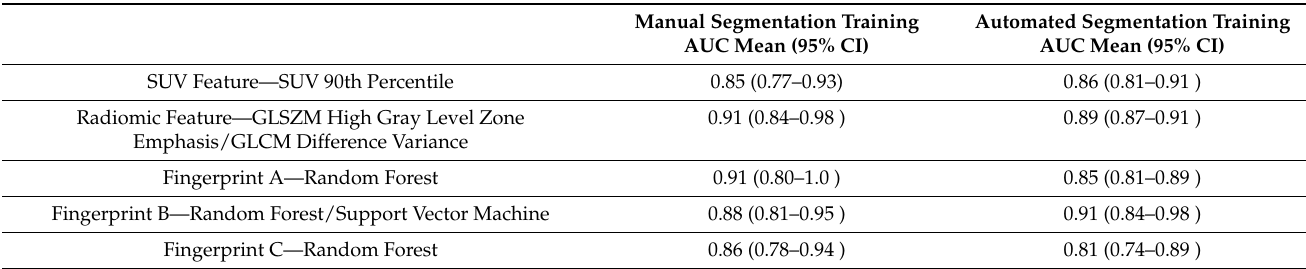
Table 7. A comparison of key results from different segmentation methods.